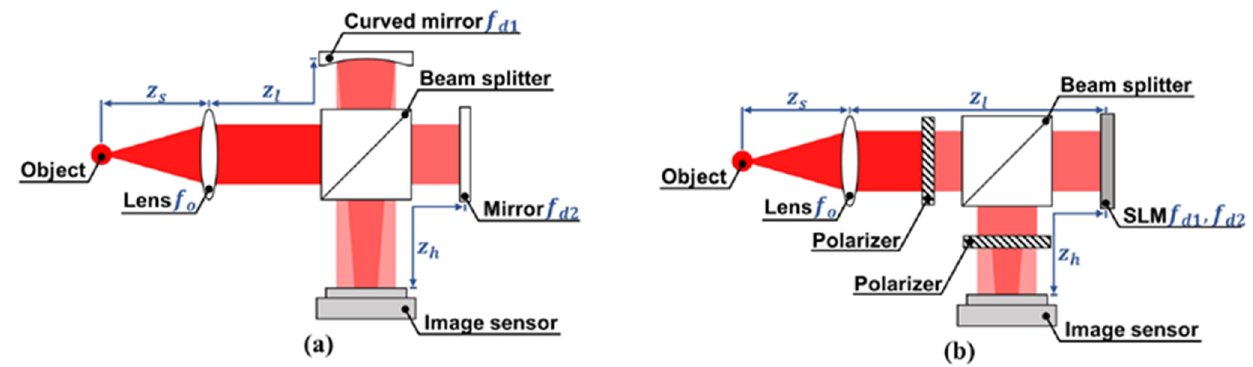
Figure 11. FINCH optical setup: ( a ) a Michelson interferometer-type imaging system; ( b ) a common-path interferometer-type based on SLM imaging system. Reprinted with permission from [12]. Copyright (2021) Optical Society of America.